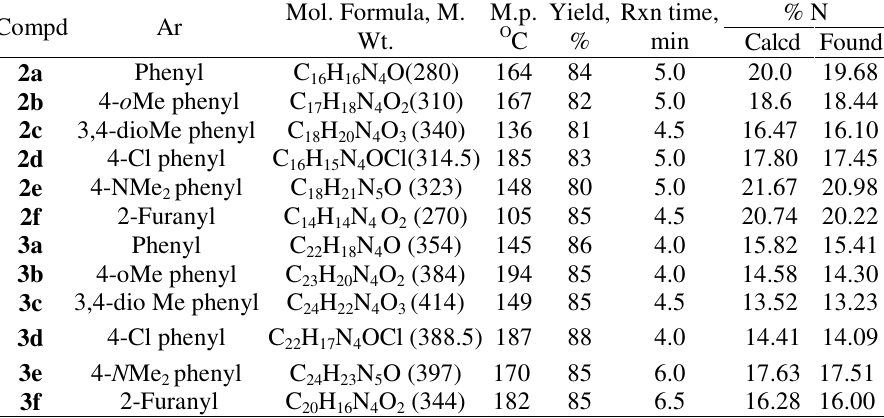
Table 1. Physical data of synthesized compounds ( 2 ) & ( 3 ).